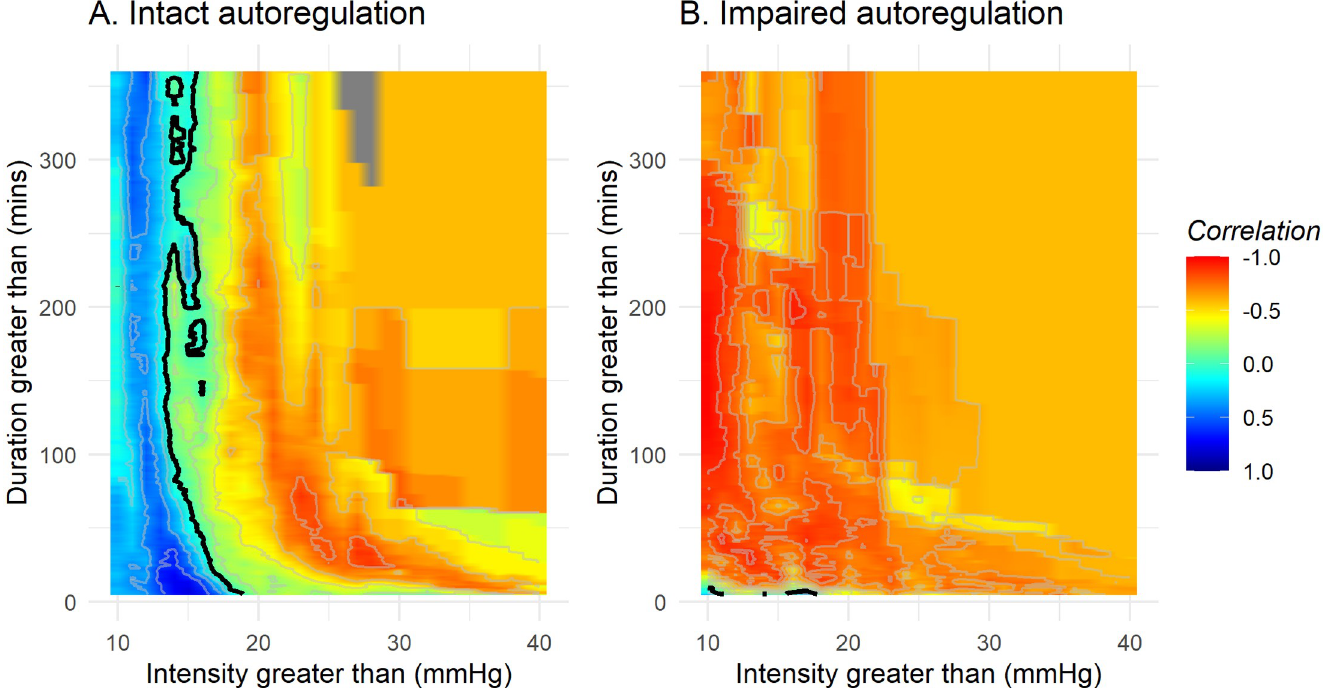
Fig 4. Correlation between number of events above thresholds of intracranial pressure intensity and duration and outcome, stratified by cerebral autoregulatory status. Orange / red areas indicates areas where ICP levels and event durations are associated with worse outcomes. The transition line, i.e. where there is no correlation between number of events and outcome, is drawn in black. All patients contribute some data to both plots, the degree however depending on the extent of their intact vs. impaired autoregulation. A) Intact autoregulation (mean PRx < = 0.3), B) Impaired autoregulation (mean PRx > 0.3).